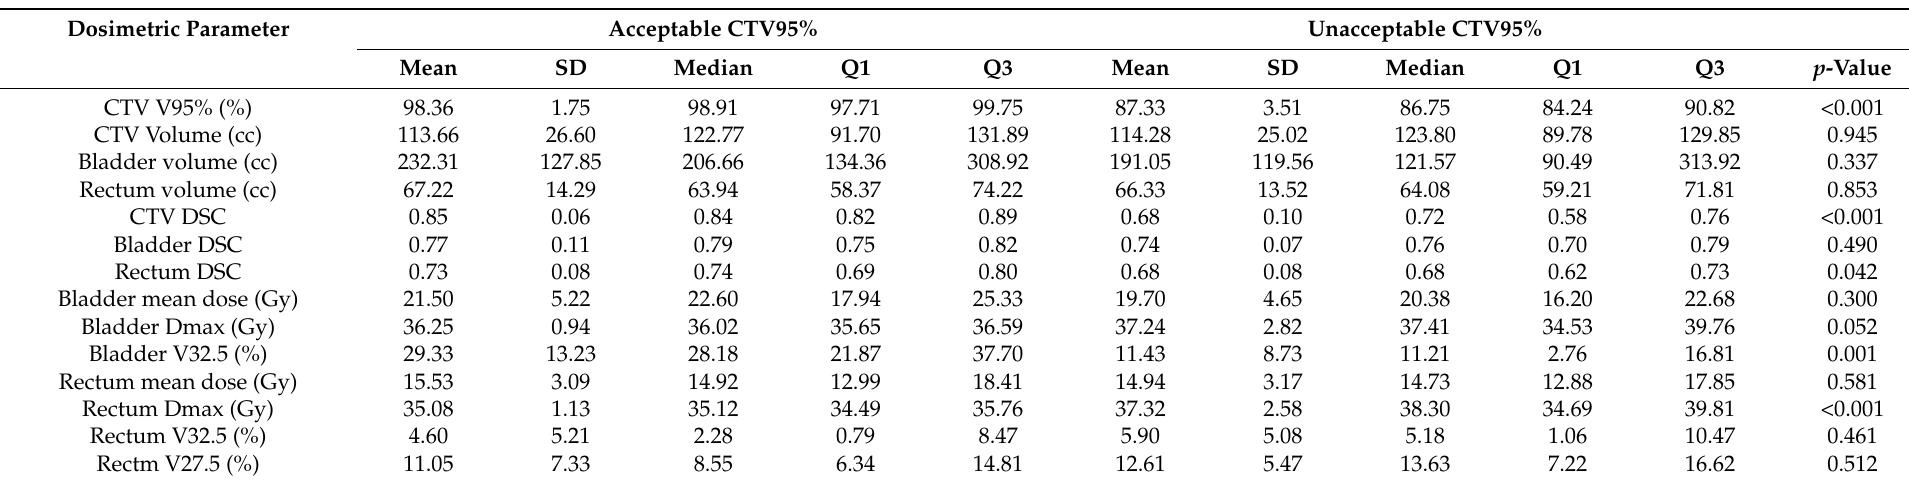
Table 3. Interfraction volume and dosimetry among patients with acceptable and unacceptable CTV V95% coverage. Dosimetric